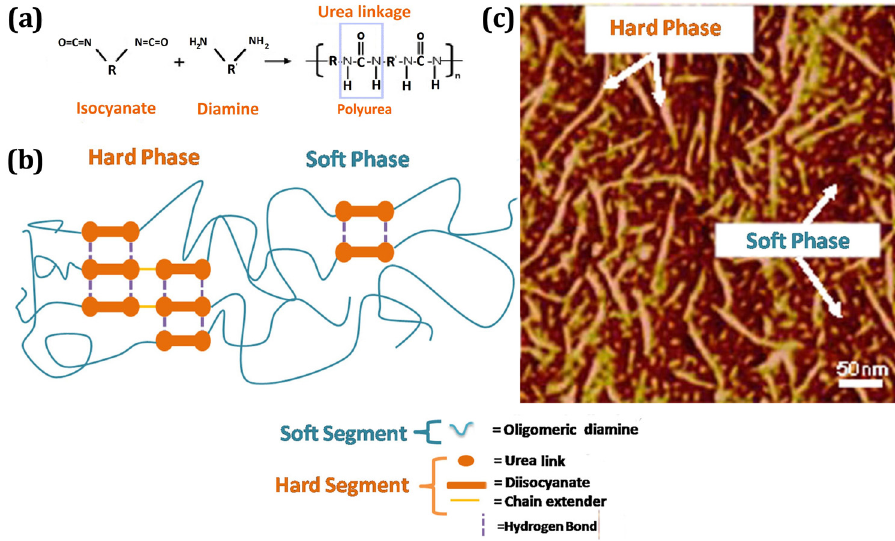
Figure 1: ( a ) Chemical reaction between diisocyanate and diamine [ 23 ] , ( b ) microphase separation in a typical polyurea molecule [ 40 ] , and ( c ) a typical tapping mode AFM image of a polyuria [ 23 ]